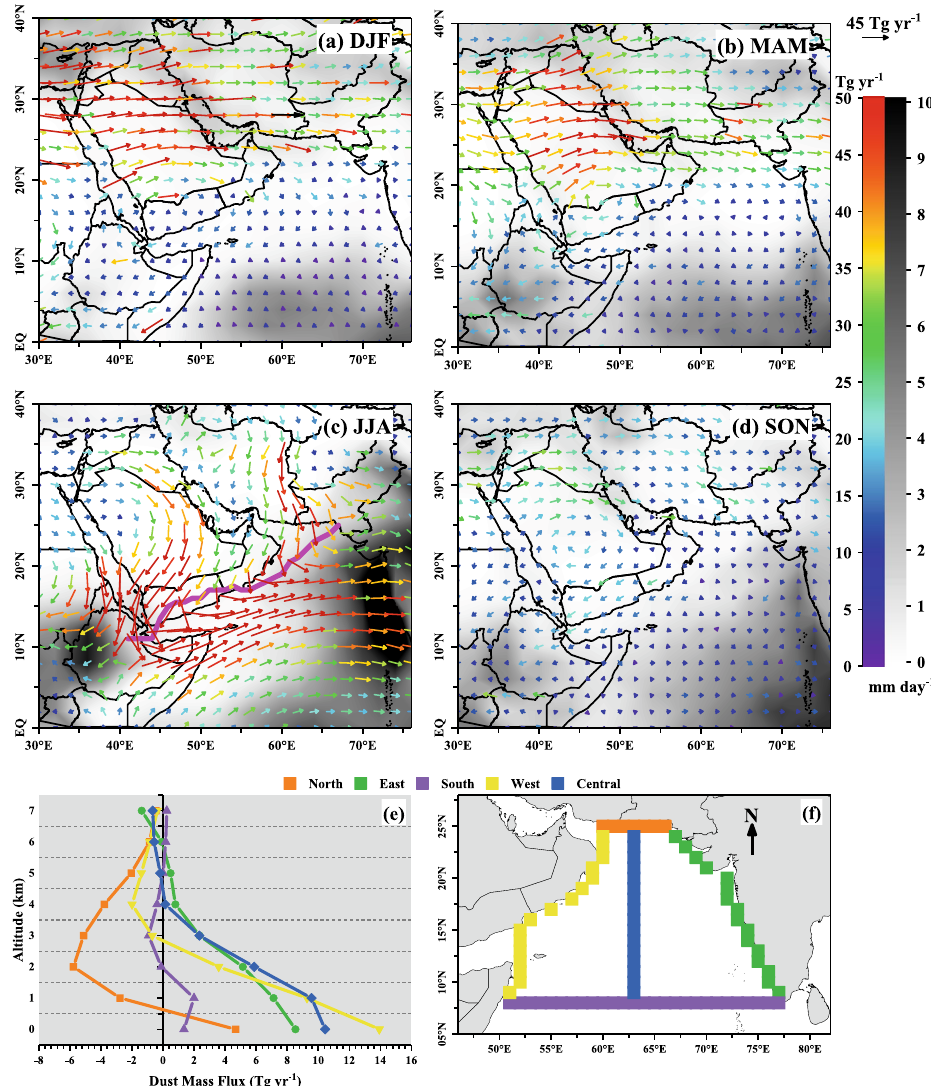
Figure 1. From 2007 to 2020 ( a–d ), seasonal and spatial distribution of dust mass flux (DMF) in terms of magnitude and direction, with color scale and the length of the vector showing the magnitude of DMF. The seasonal precipitation rate, derived from the Global Precipitation Measurement (GPM), is also shown (grey contour). ( e ) The average zonal and meridional DMF at the boundaries of the AS (as shown in the bottom right panel—( f ) at different vertical regimes during JJA. The values of DMF are positive (negative) for north (south) boundaries when the direction of flux is from south to north (from north to south). For the west, central and east boundaries, positive (negative) DMF represents the direction of flux from west to east (from east to west). The location of ITD (the area of near-zero meridional wind at 850 hPa estimated from the MERRA-2 reanalysis data for the period 2007–2020) is shown in ( c ) by the solid magenta